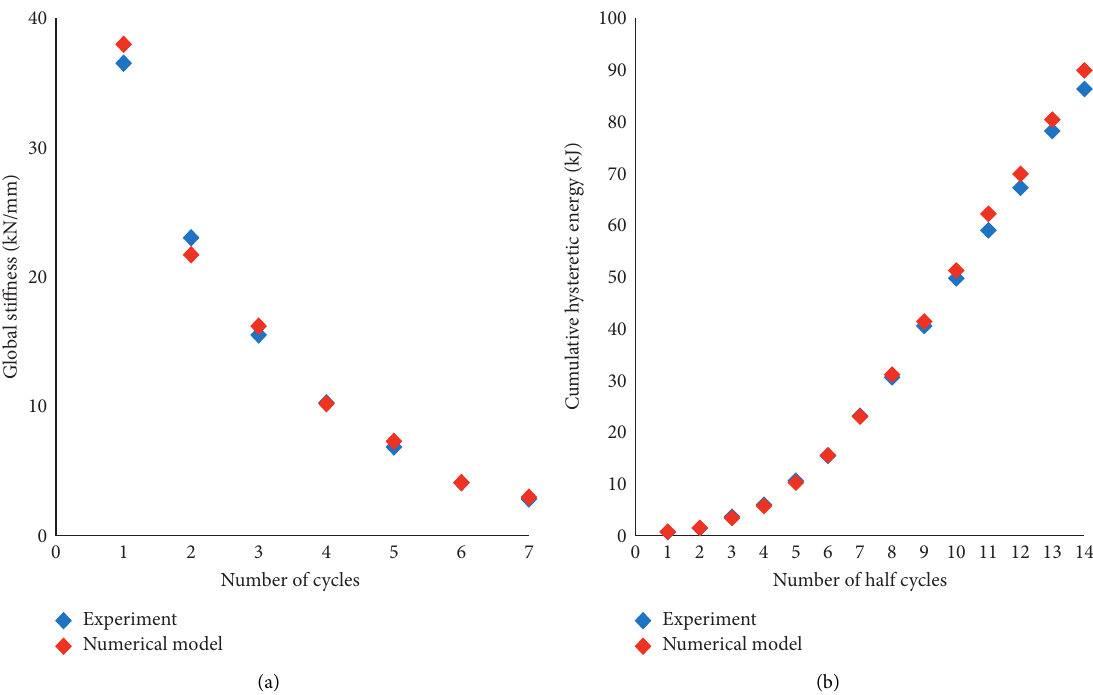
Figure 8: Comparison between the numerical model and the experimental results for the TRM masonry-infilled frame in terms of the (a) global lateral stiffness per cycle and (b) cumulative global hysteretic energy per half